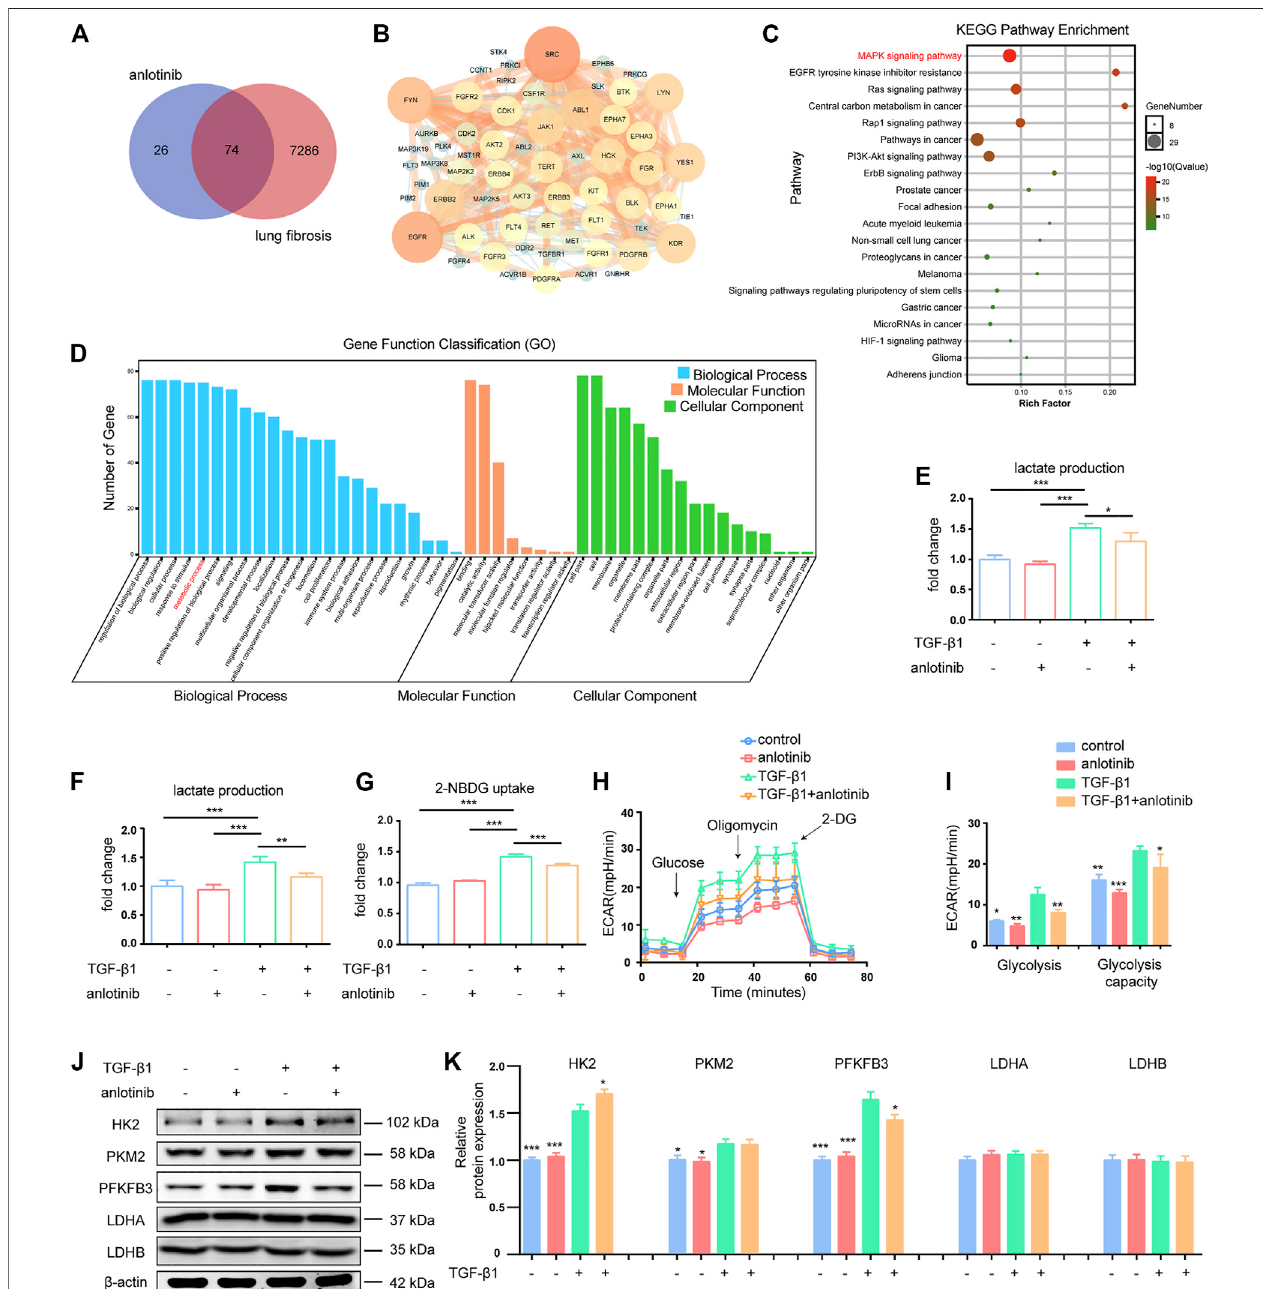
FIGURE 2 | Anlotinib inhibits PFKFB3-driven glycolysis in lung myo fi broblasts. (A) Venn diagram to show the overlaps between anlotinib targets and lung fi brosis- related targets. (B) Protein-protein interaction (PPI) network of common targets between anlotinib and IPF. (C) The KEGG enrichment analysis of 74 targets of common targets. (D) The GO enrichment for each section listed. The mouse lung fi broblasts were pretreated with anlotinib (1 µM) for 3 h and then exposed to TGF- β 1 (10 ng/ml) foranadditional24h,andthenthecellswerelysedandlactatecontentsinthecellularlysates (E) andculturemedia (F) weredetermined.Thedataarepresentedas foldchangerelativetothelevelsoftheuntreated controlgroup(mean ± SD,n (cid:1) 3). (G) Glucoseuptakedetected with2-NBDGweredetermined.Thedataarepresented asfoldchangerelativetothelevelsoftheuntreatedcontrolgroup(mean ± SD,n (cid:1) 3). (H) Extracellularacidi fi cationrate(ECAR)wasassessed. (I) Glycolysisandglycolysis capacity were quanti fi ed and shown as histograms (mean ± SD, n (cid:1) 3). (J) Western blot analysis of HK2 、 PKM2 、 PFKFB3 、 LDHA and LDHB, β -actin was used as a loading control. (K) Quanti fi cation ofHK2 、 PKM2 、 PFKFB3 、 LDHA and LDHB protein levels relative to β -Actin isshown (mean ± SD, n (cid:1) 3). I, K,* p < 0.05, ** p < 0.01, *** p < 0.001 VS TGF- β 1-treated group by ANOVA.